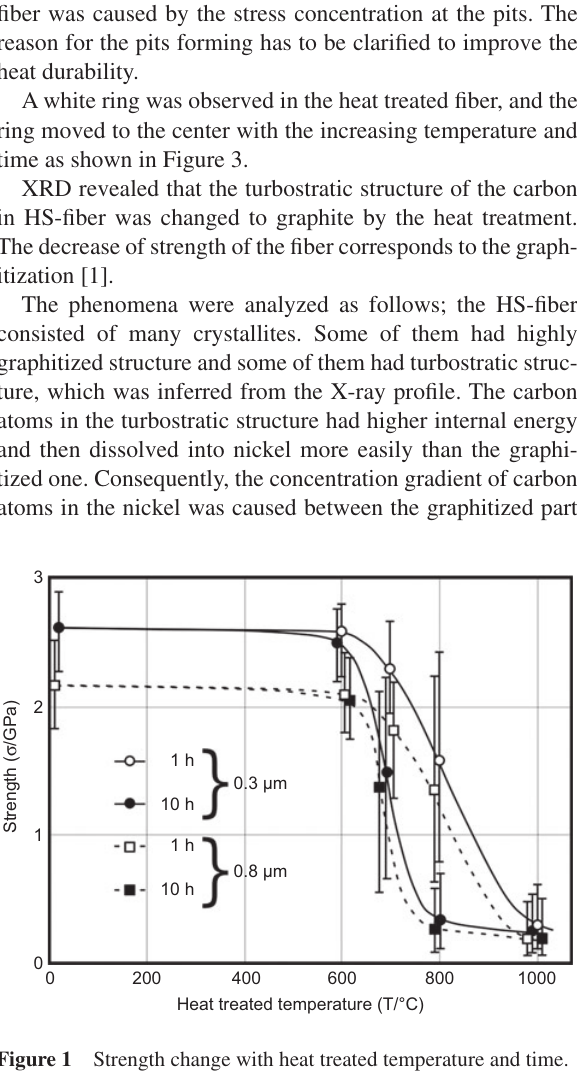
Figure 1 Strength change with heat treated temperature and time.